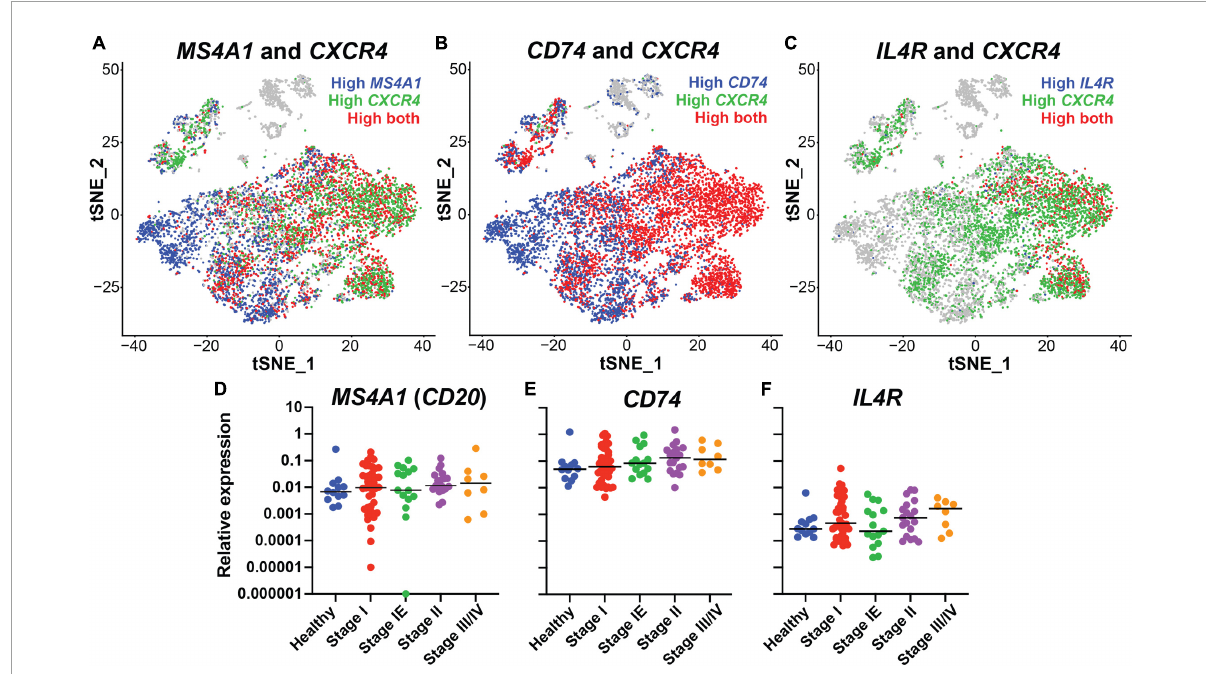
FIGURE1 CD74 and IL4R identified as good candidates for bispecific antibody development, in conjunction with CD20, by single cell RNA sequencing. (A) tSNE plot of MS4A1 (Blue) and CXCR4 (Green). (B) tSNE plot of CD74 (Blue) and CXCR4 (Green). (C) tSNE plot of IL4R (Blue) and CXCR4 (Green). (D) Relative expression of MS4A1 in samples collected from healthy donors and donors with lymphoma at different stages of disease. Each dot represents one individual. (E) Relative expression of CD74 in samples collected from healthy donors and donors with lymphoma at different stages of disease. (F) Relative expression of IL4R in samples collected from healthy donors and donors with lymphoma at different stages of disease. n = 12 healthy, 41 stage I, 15 stage IE, 19 stage II, 8 stage